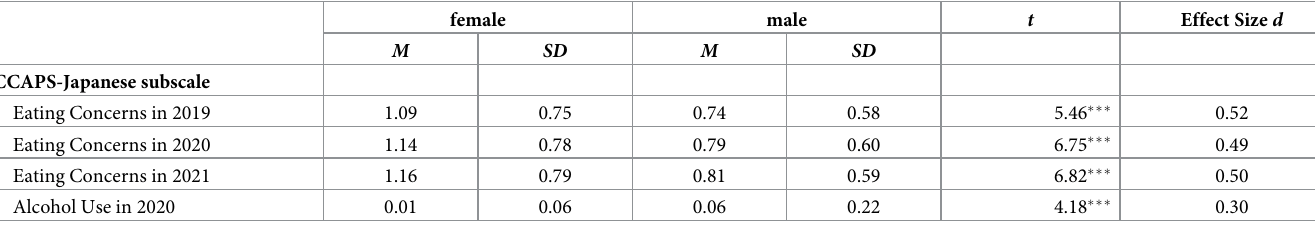
Table 3. Sex differences in the CCAPS-Japanese